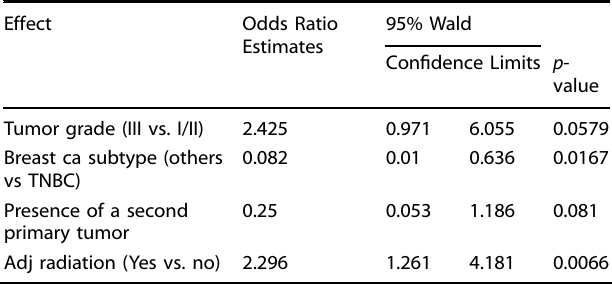
Table 4. Multivariable logistic regression of potential clinical factors in brain metastasis ( n = 258 gBRCA1 and non-carrier